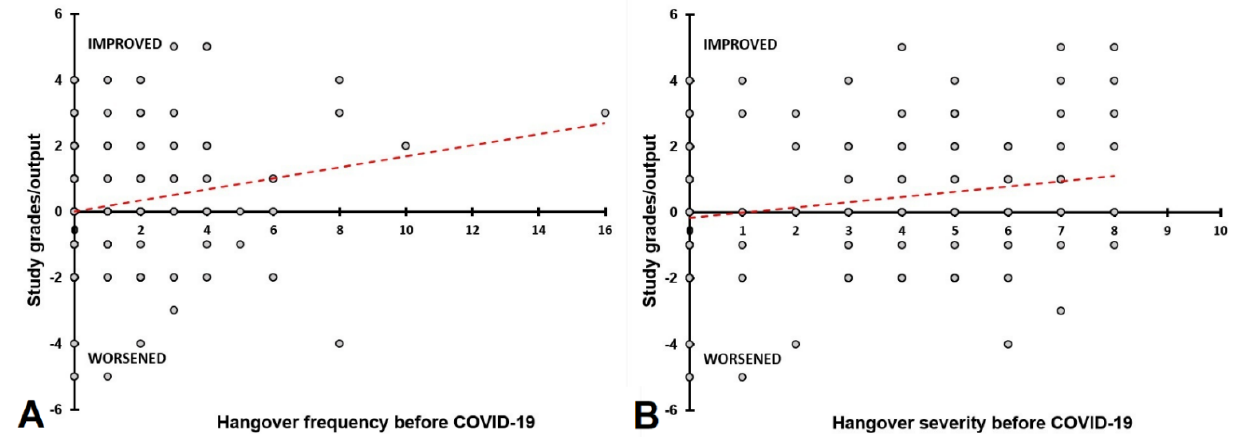
Figure 6. Relationship between having hangovers before COVID-19 and study grades/output during the COVID-19 pan- demic. Spearman’s correlations are shown between hangover assessments made for ‘before COVID-19′ and study grades/output during the COVID-19 pandemic (the difference score relative to ‘before COVID-19′). Correlations are shown for hangover frequency ( A ) and hangover severity ( B ).